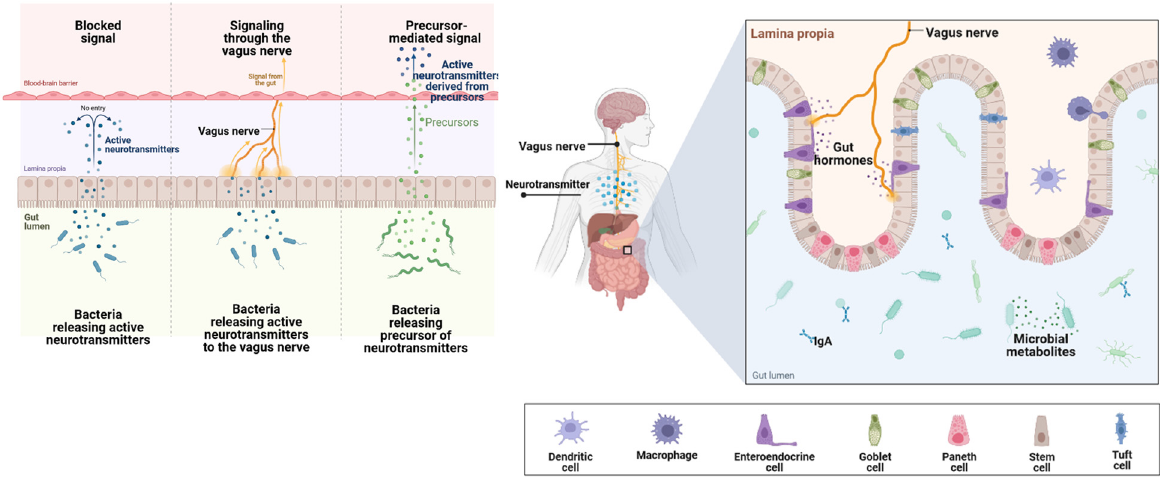
Figure 4. Gut-brain